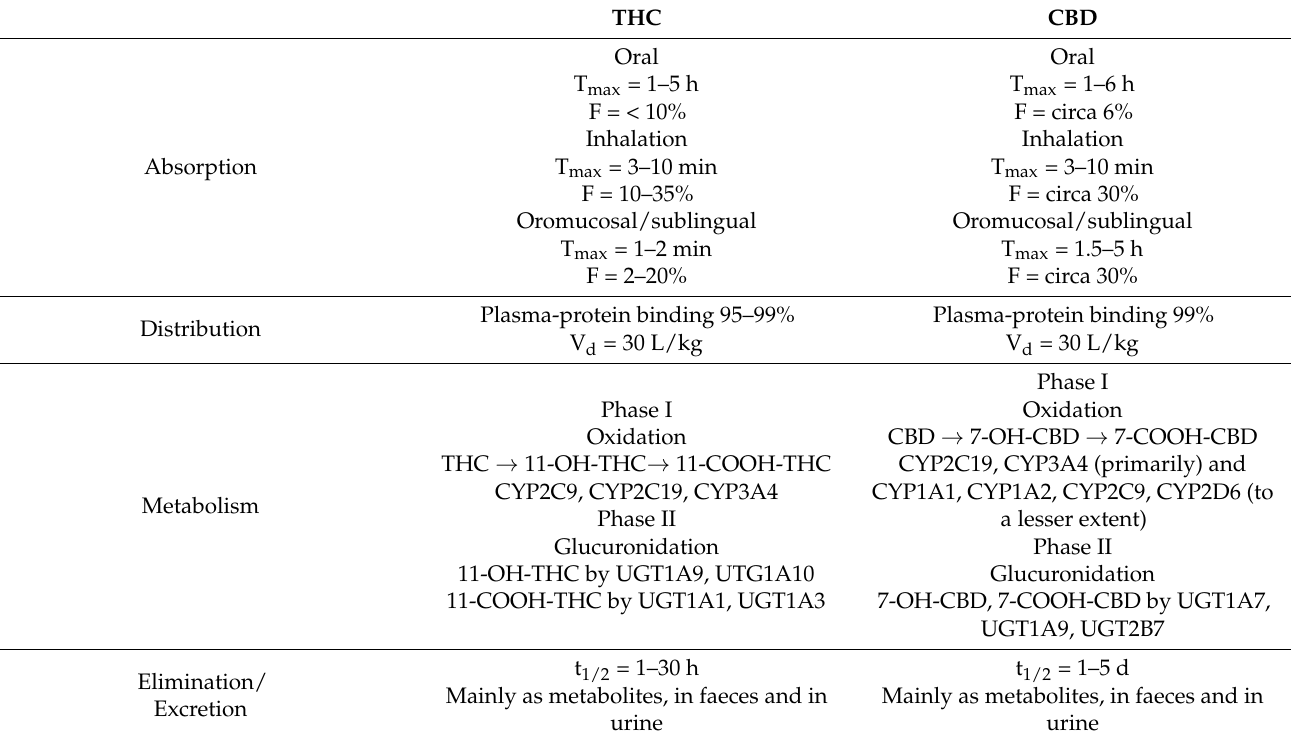
Table 3. Main pharmacokinetic data of both cannabinoids as found in the literature, in relation to the administration route